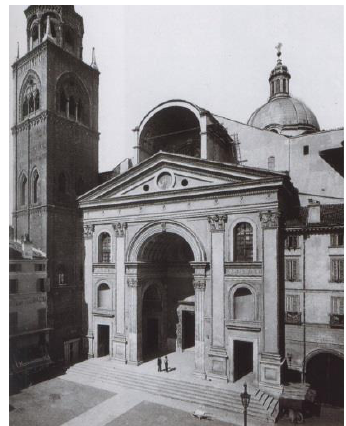
Fig. 9 Sant’ Andrea, Mantua (Alberti, 1460) 3. THE MODERN ERA: